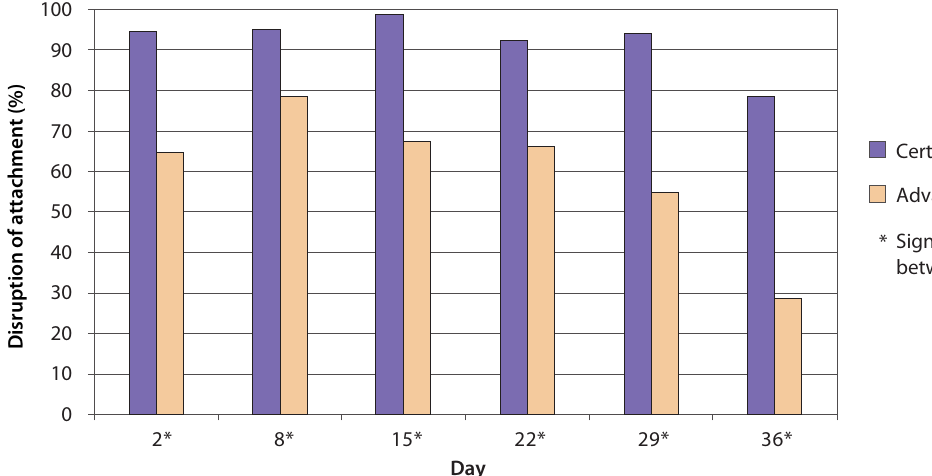
Fig 1. – Disruption of attachment of Dermacentor reticulatus at 24-hour post-infestation.